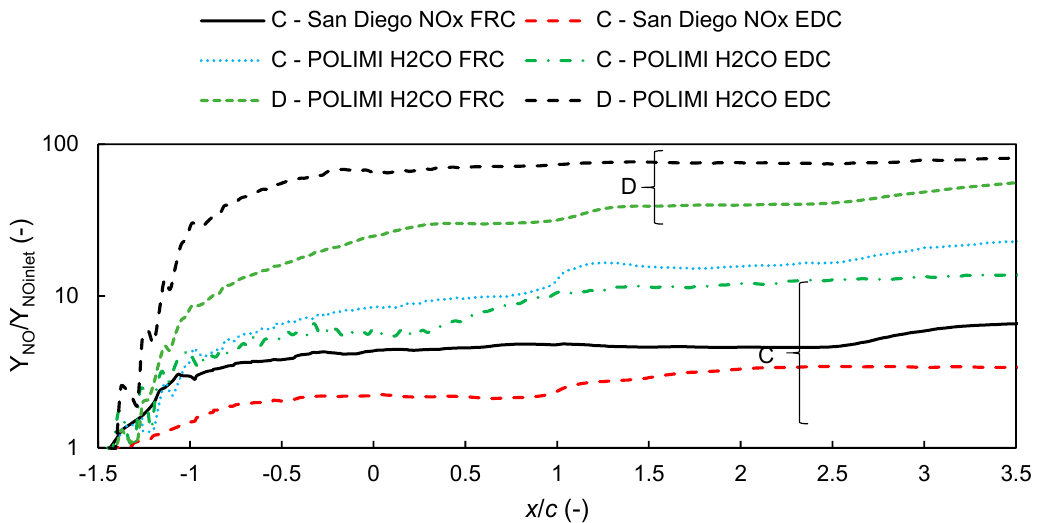
Figure 11. NO mass fractions for conditions C (cruise, H 2 ) and D (cruise, CH 4 ) calculated utilising the CFD model with different chemical reaction mechanisms and chemistry modelling.